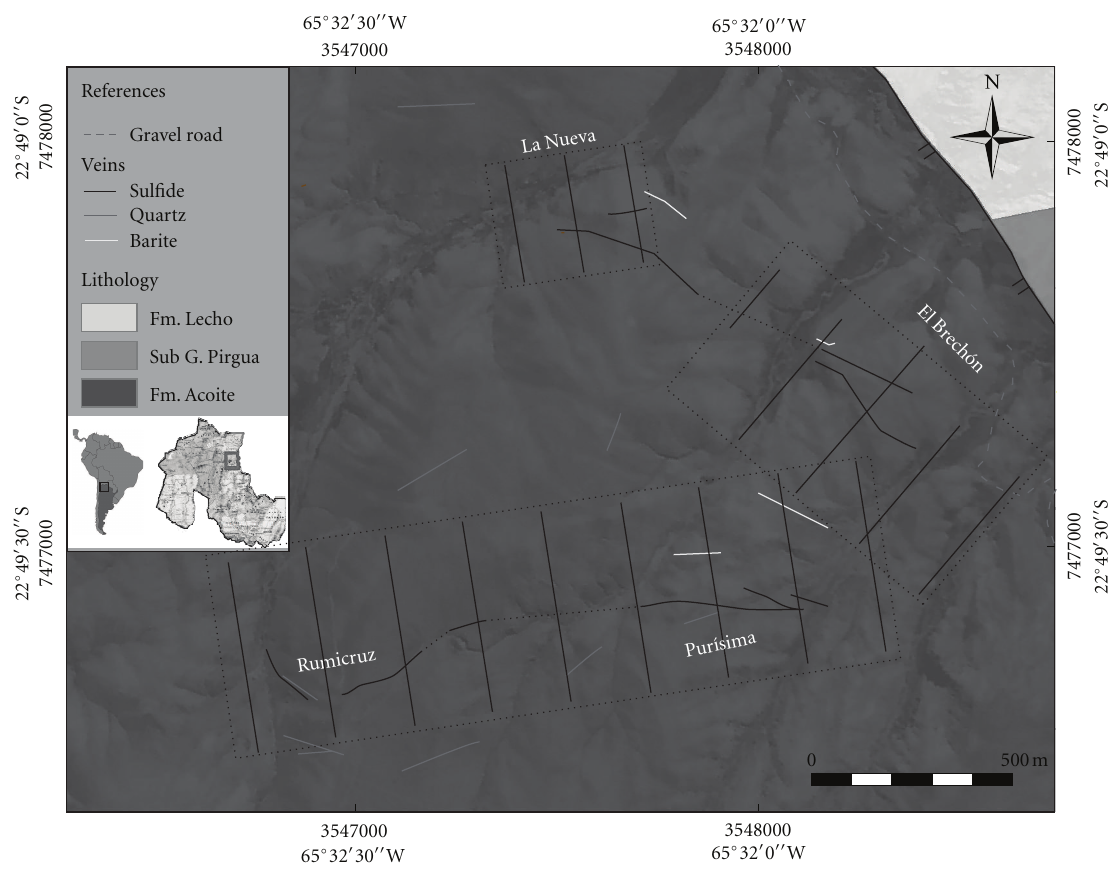
Figure 1: Simplified geologic map of Pur´ısima-Rumicruz district and survey lines